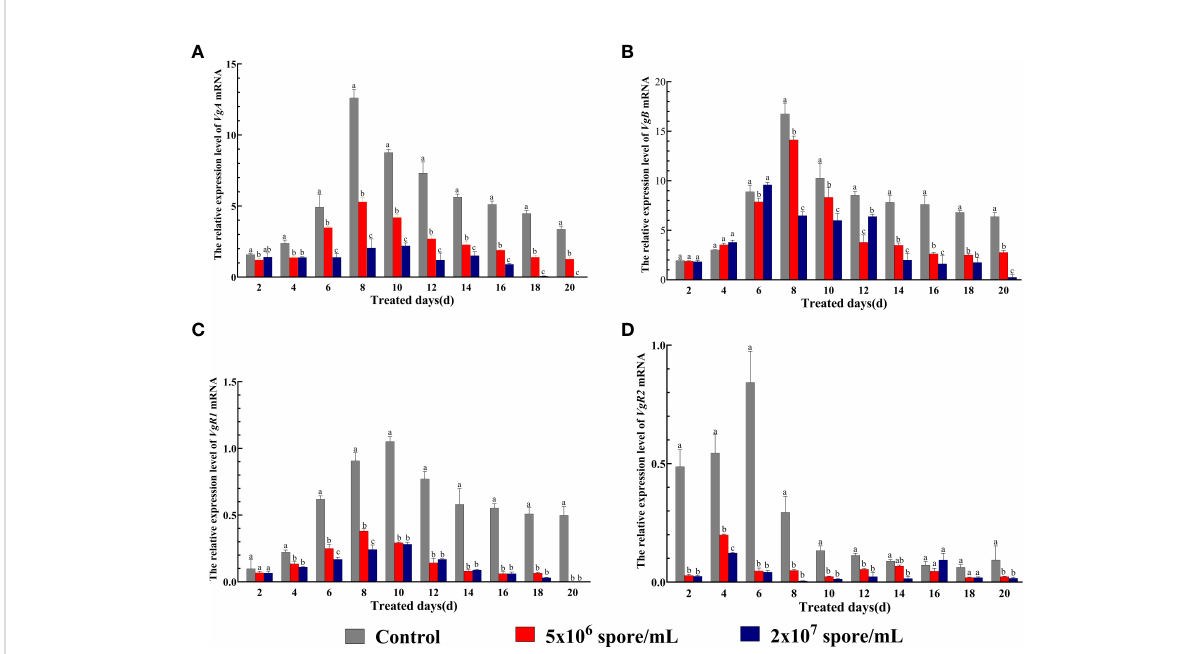
FIGURE 3 Expression of on Vg and VgR genes in expression after L. migratoria manilensis was infected by P. locustae . (A) Relative expression of VgA mRNA in adult females infected by P. locustae on days 2 – 20. (B) Relative expression of VgB mRNA in adult females infected by P. locustae on days 2 – 20. (C) Relative expression of VgR1 mRNA in adult females infected by P. locustae on days 2 – 20. (D) Relative expression of VgR2 mRNA in adult females infected by P. locustae on days 2 – 20. Each value is presented as mean ± SD, and different letters indicate signi fi cant differences among different treatments at the same time point (two-way ANOVA followed by Tukey ’ s multiple comparisons test, P <